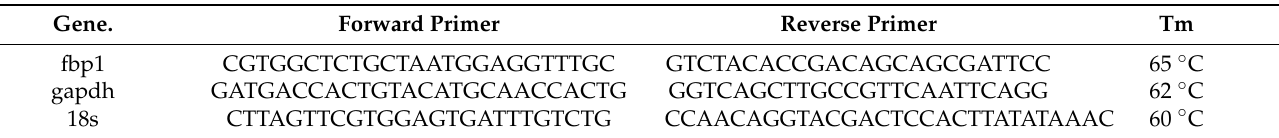
Table 2. Sequences of specific primers used in the real-time quantitative PCR. Gene.